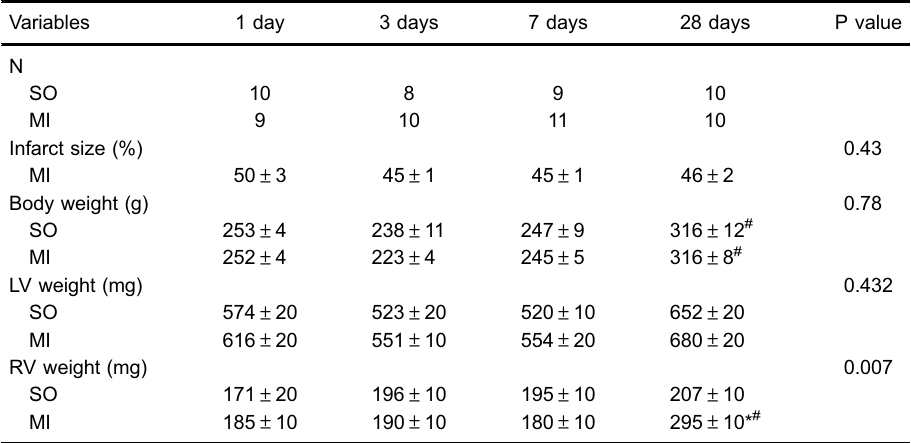
Table 1. Morphological data of rats studied at different times after myocardial infarction (MI) or sham- operation (SO).